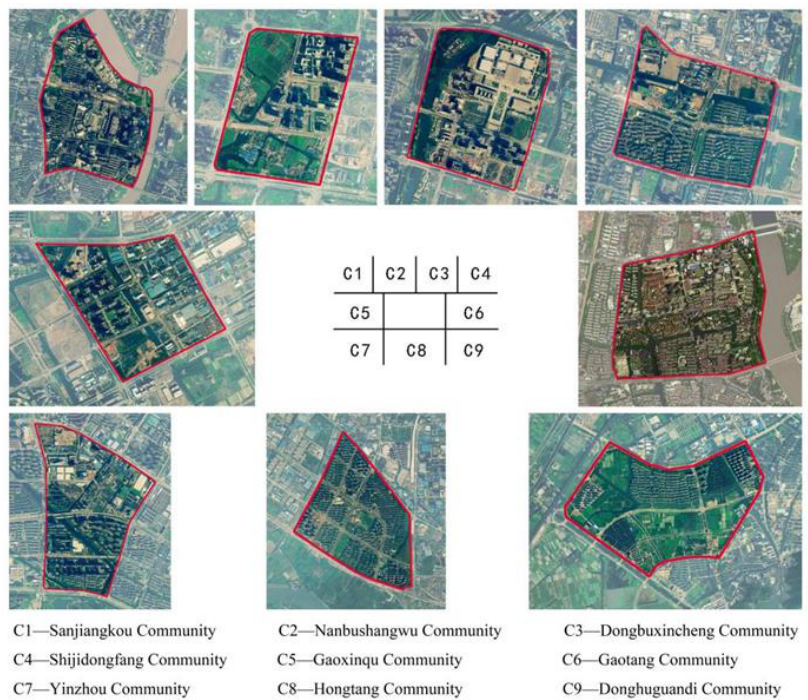
Figure 2. Images of the nine communities across Ningbo used in the study, accessed 12 October 2015. Photograph: Baidu